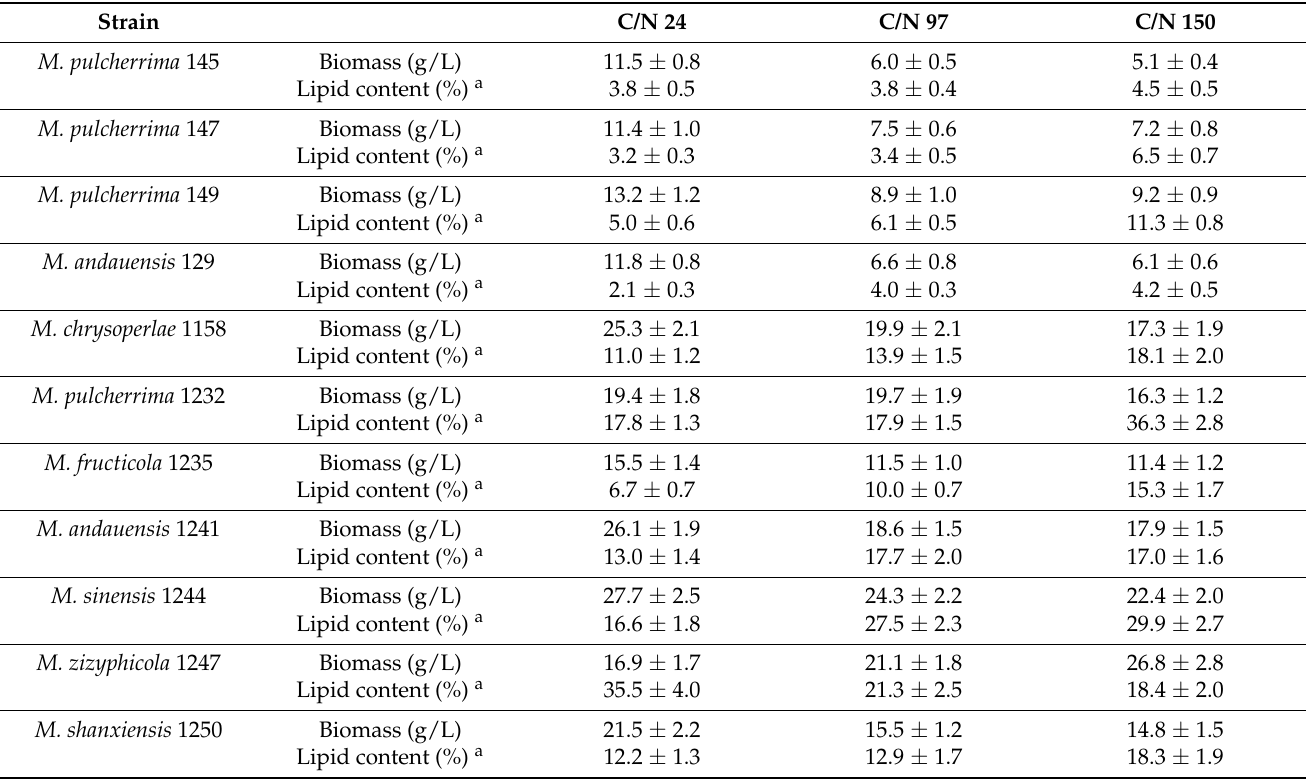
Table 6. Production biomass and lipids at low temperature cultivated on glycerol medium with different C/N ratio.